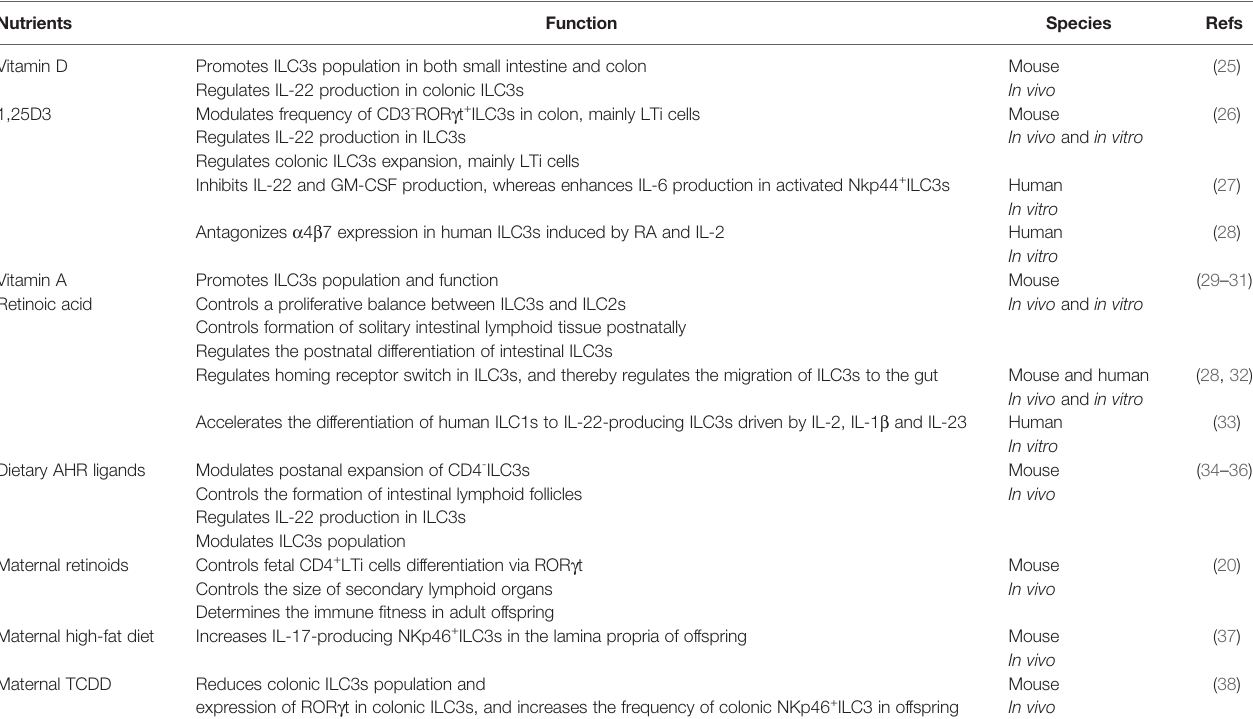
TABLE 1 | Metabolic regulation of ILC3s by nutrient-derived metabolites. Nutrients Function Species Refs Vitamin D